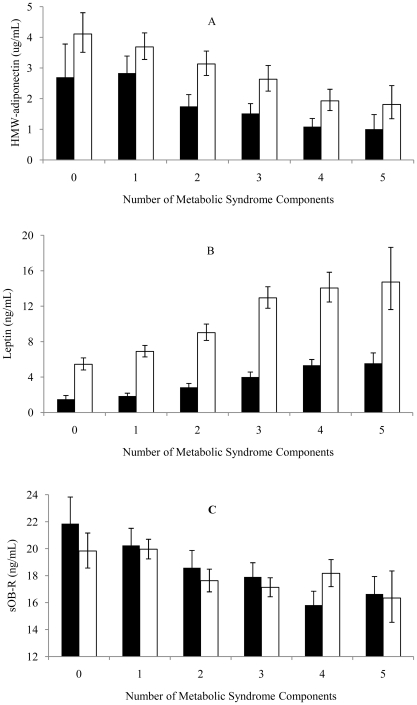
Geometric means (95%CI) of concentrations of HMW-adiponectin (A), leptin (B) and soluble leptin receptor (sOB-R, C) in individuals with 0 to 5 components of metabolic syndrome.Black bars  =  Men; white bars  =  Women. All P values were <.0001.